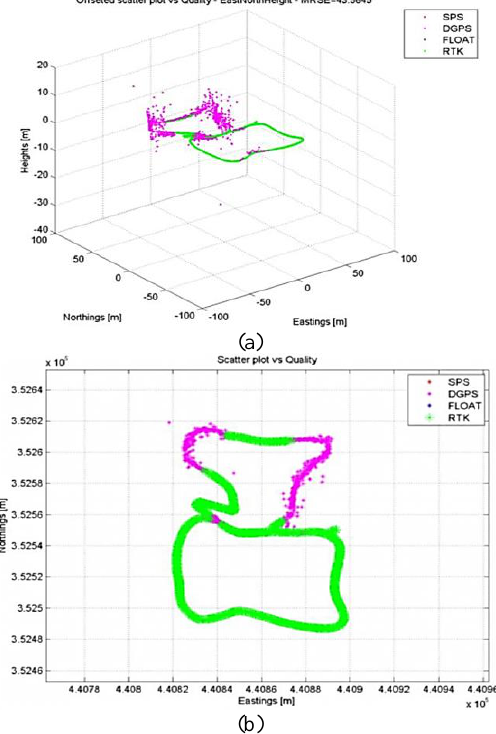
Figure 2. Mobile Kinematic Results: (a) GS10 Mobile Kinematic 3D; (b) GS10 Mobile Kinematic